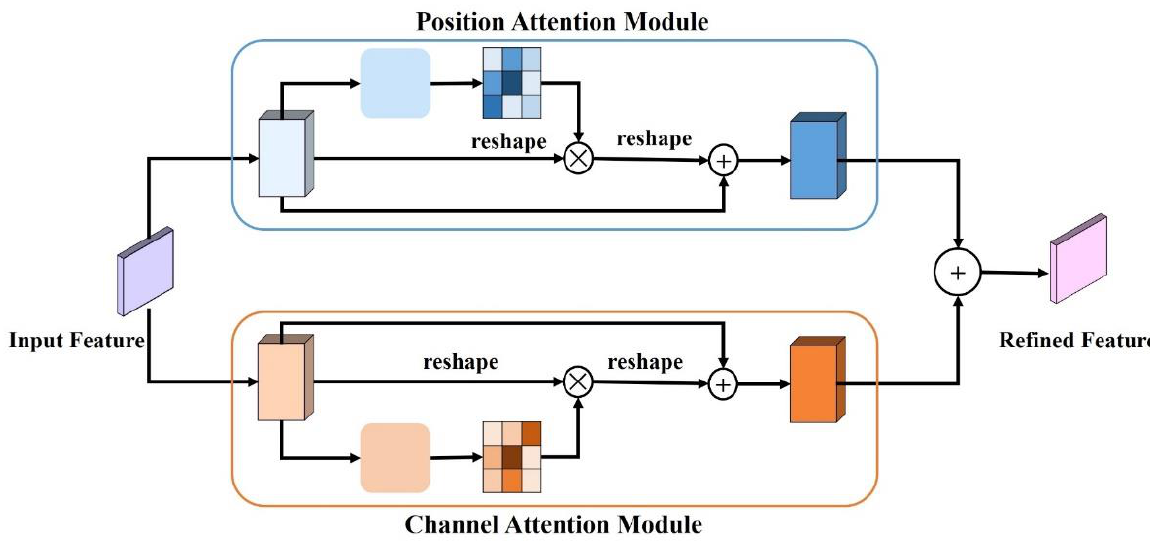
Figure 2. Structure of the Dual Attention (DA) module.